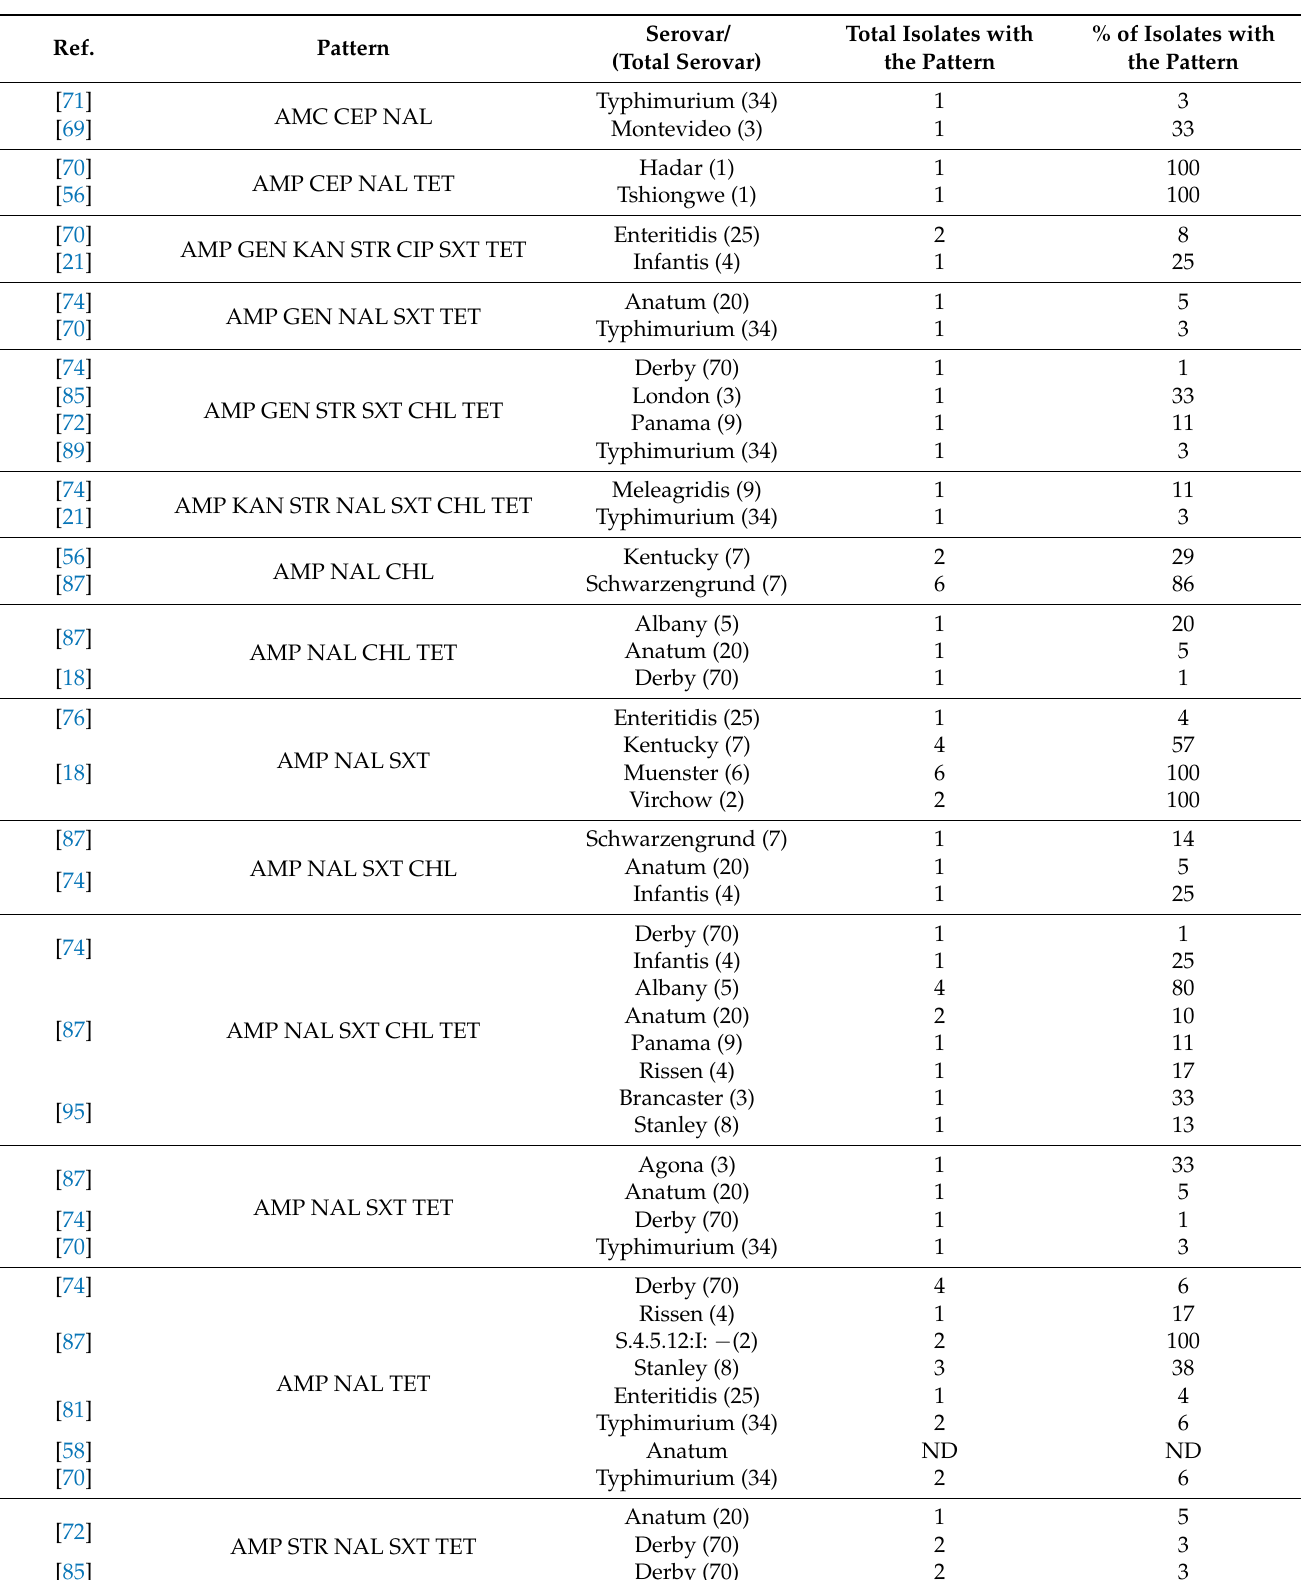
Table 5. Patterns of multidrug resistant Salmonella serovar as determined by disc diffusion.